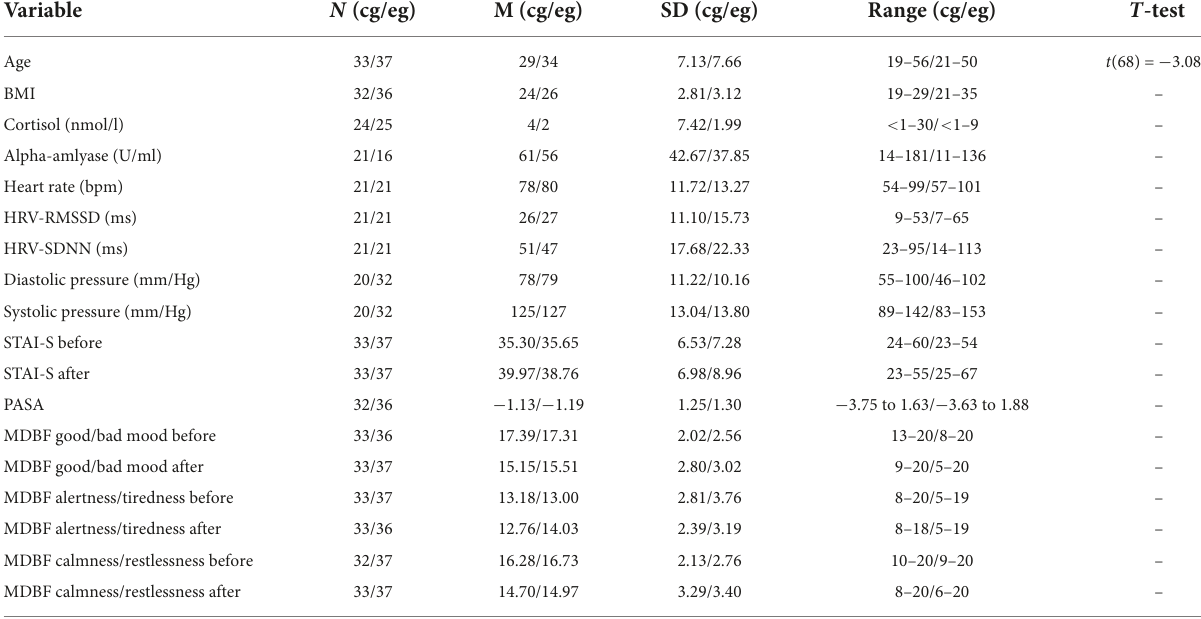
TABLE 1 Descriptive data for male soldiers with and without mission abroad.